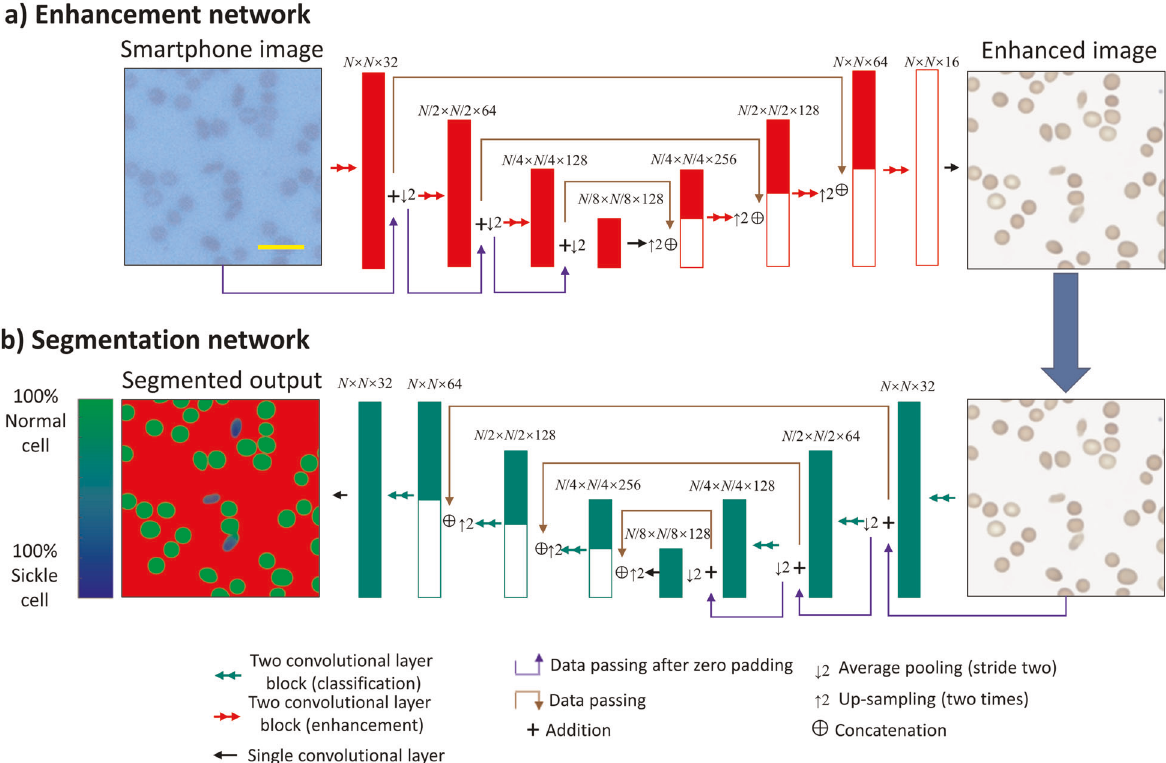
Fig. 5 Deep neural network architecture. Diagram detailing the network architecture for both a the image enhancement network and b the semantic segmentation network. The numbers above the layers represent the size of the tensor dimensions at that point in the network, in the format: length × width × number of channels. N was chosen to be 128 during training and can be set to any arbitrary size during testing. Scale bar indicates 20 μ